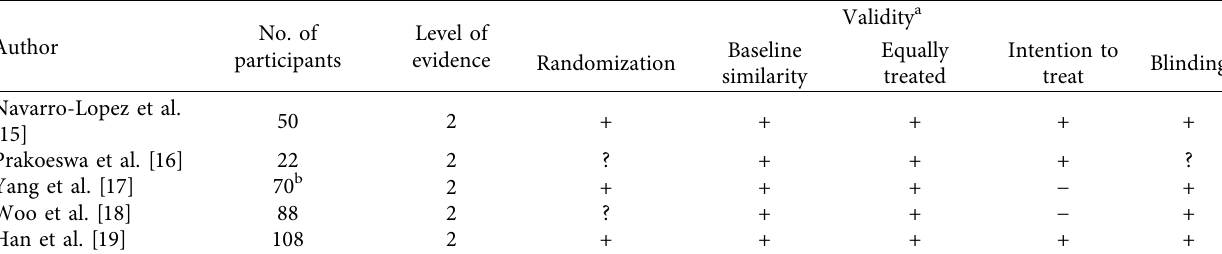
Table 2: Validity appraisal of RCTs based on CEBM critical appraisal